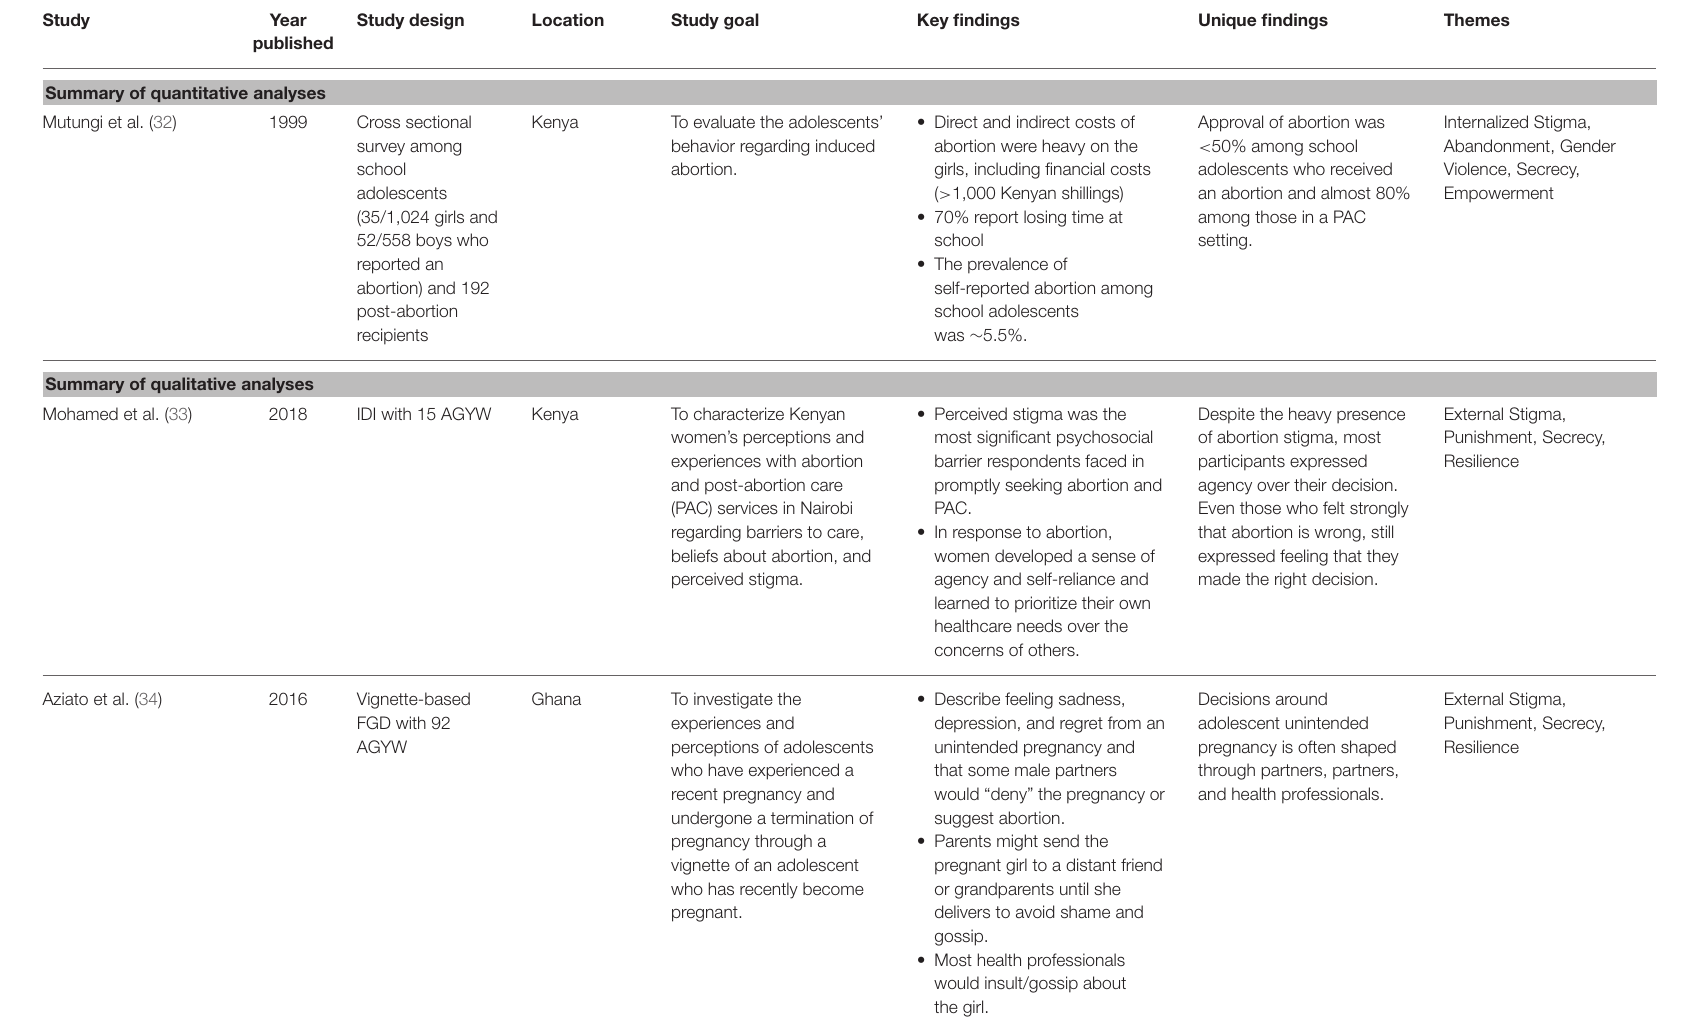
TABLE 1 | Summary of articles of psychosocial outcomes of adolescent girls and young women in